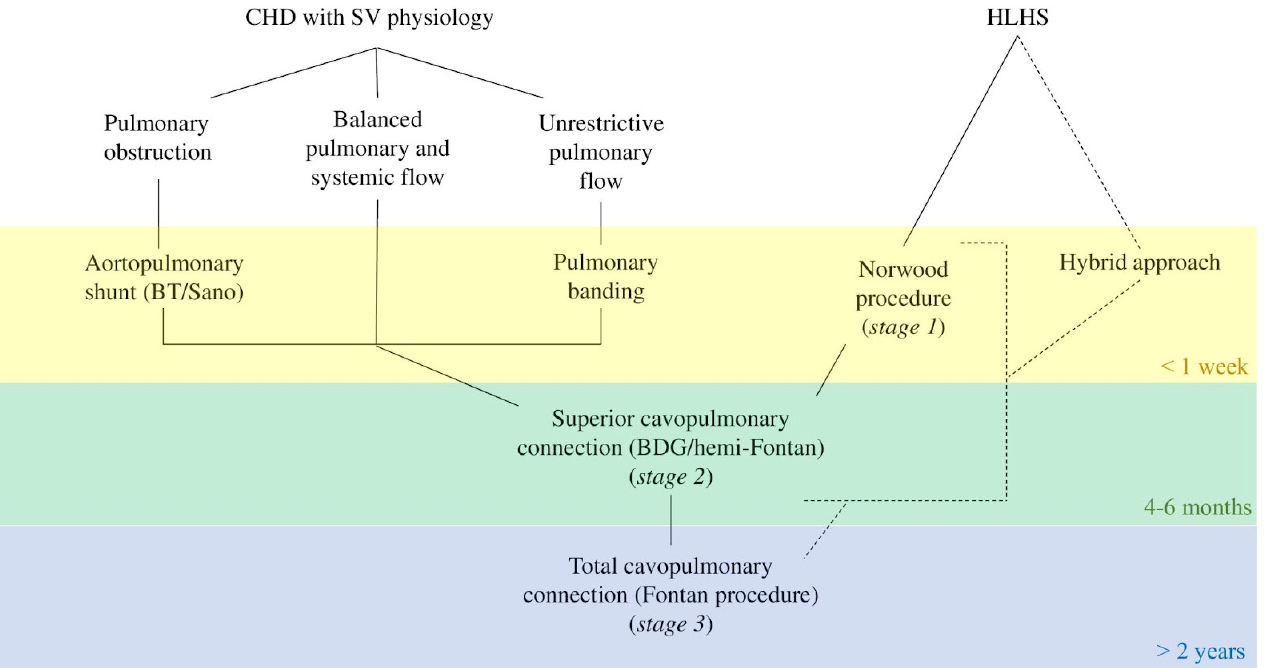
Figure 2. Scheme of more common surgical stages ending with Fontan procedure. Abbreviations: BDG, bidirectional Glenn; BT, Blalock–Taussig; CHD, congenital heart defects; HLHS, hypoplastic left heart syndrome; SV, single ventricle.